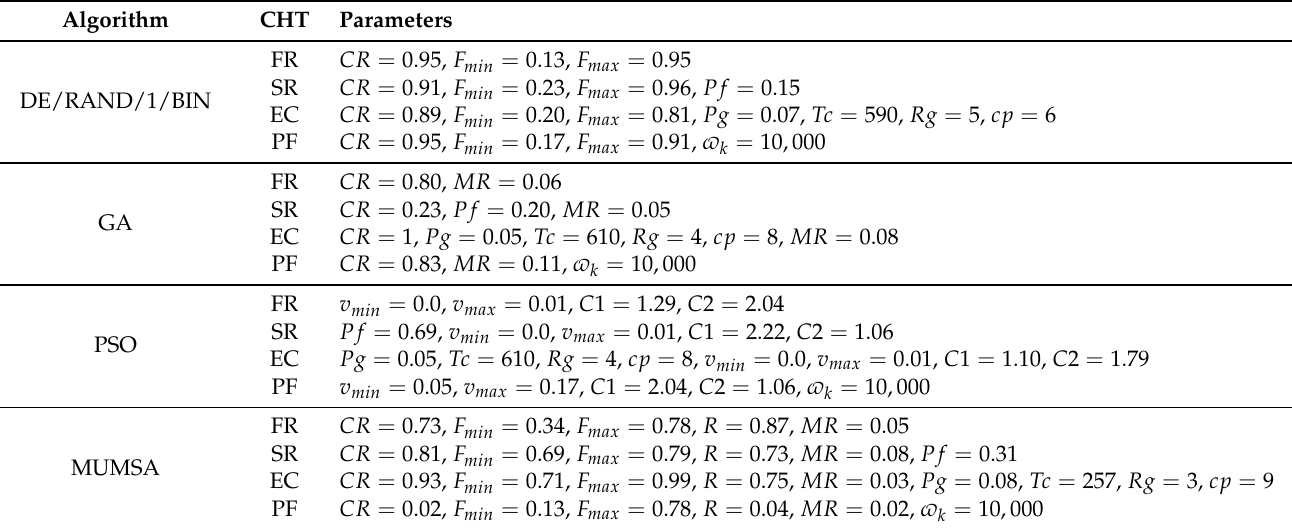
Table 2. Algorithm parameter setting obtained by an irace package in study case